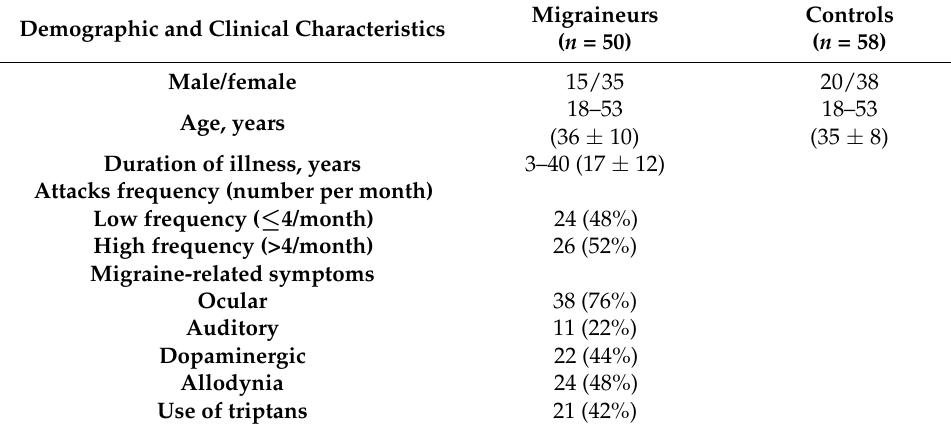
Table 1. Demographic and clinical characteristics of the studied groups. Demographic and Clinical